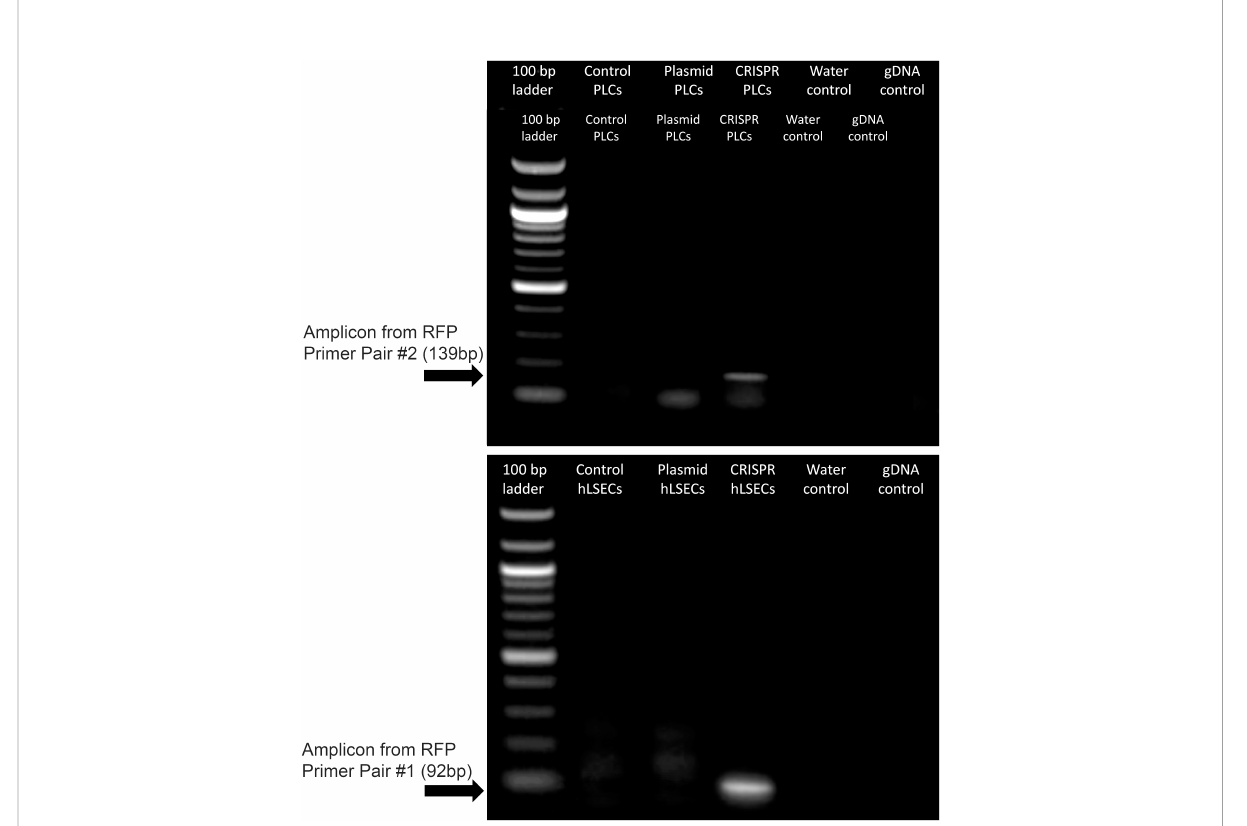
FIGURE 11 Expression of RFP in gene-modi fi ed PLCs and hLSECs by RT-qPCR. RNA was isolated from PLCs and hLSECs that were unmodi fi ed, transiently transfected with a plasmid encoding RFP, or had RFP permanently knocked-in via CRISPR/Cas9-mediated editing. RNA was isolated from the transfected cells after culture expansion and 3 passages and from the CRISPR/Cas9 edited cells following puromycin selection. RNA was then subjected to RT-qPCR and the resultant PCR products run on an agarose gel. Controls included no template/water and genomic DNA to con fi rm complete elimination of any contaminating gDNA by the RNase-free DNase